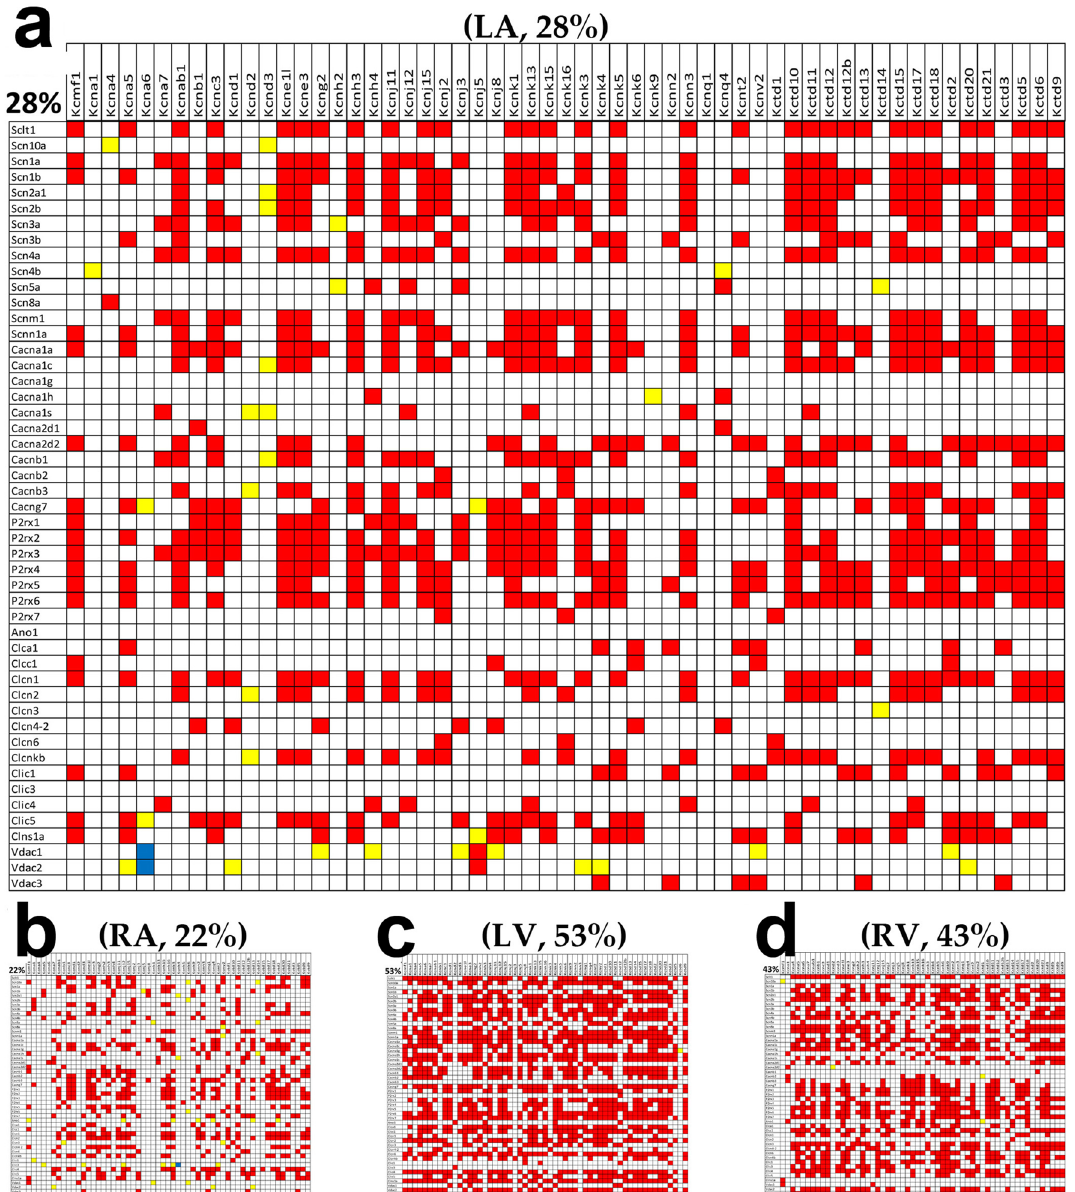
Figure 8. Significant (p < 0.05) expression correlation and independence of the 57 potassium channel genes with the 49 sodium, calcium and chloride channel genes in ( a ) left atrium, ( b ) right atrium, ( c ) left ventricle, ( d ) right ventricle. Red/blue/yellow square indicates that the potassium channel gene labeling the column and the sodium/calcium/chloride channel labeling the intersected row are significantly synergistically/antagonistically/ independently expressed. Numbers above the graphs represent the percentages of synergistic pairs within the gene selection in the indicated